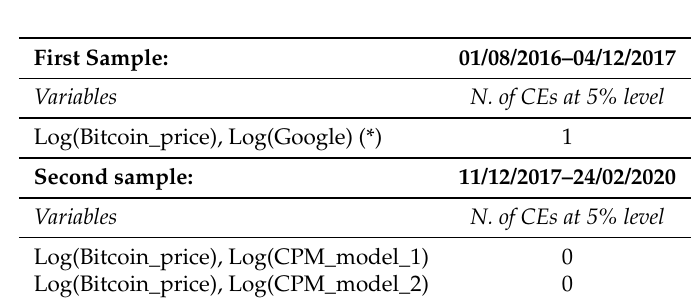
Table A12. Multivariate Johansen cointegration tests. The null hypothesis is the absence of cointegration. The tests considered either the case of an intercept in the cointegration equa- tion (CE) and a trend in the variables (first sample) or the case of an intercept in the CE only (second sample). (*) The final model turned out to be the same, independently of whether we used the CPM1 or the CPM2.